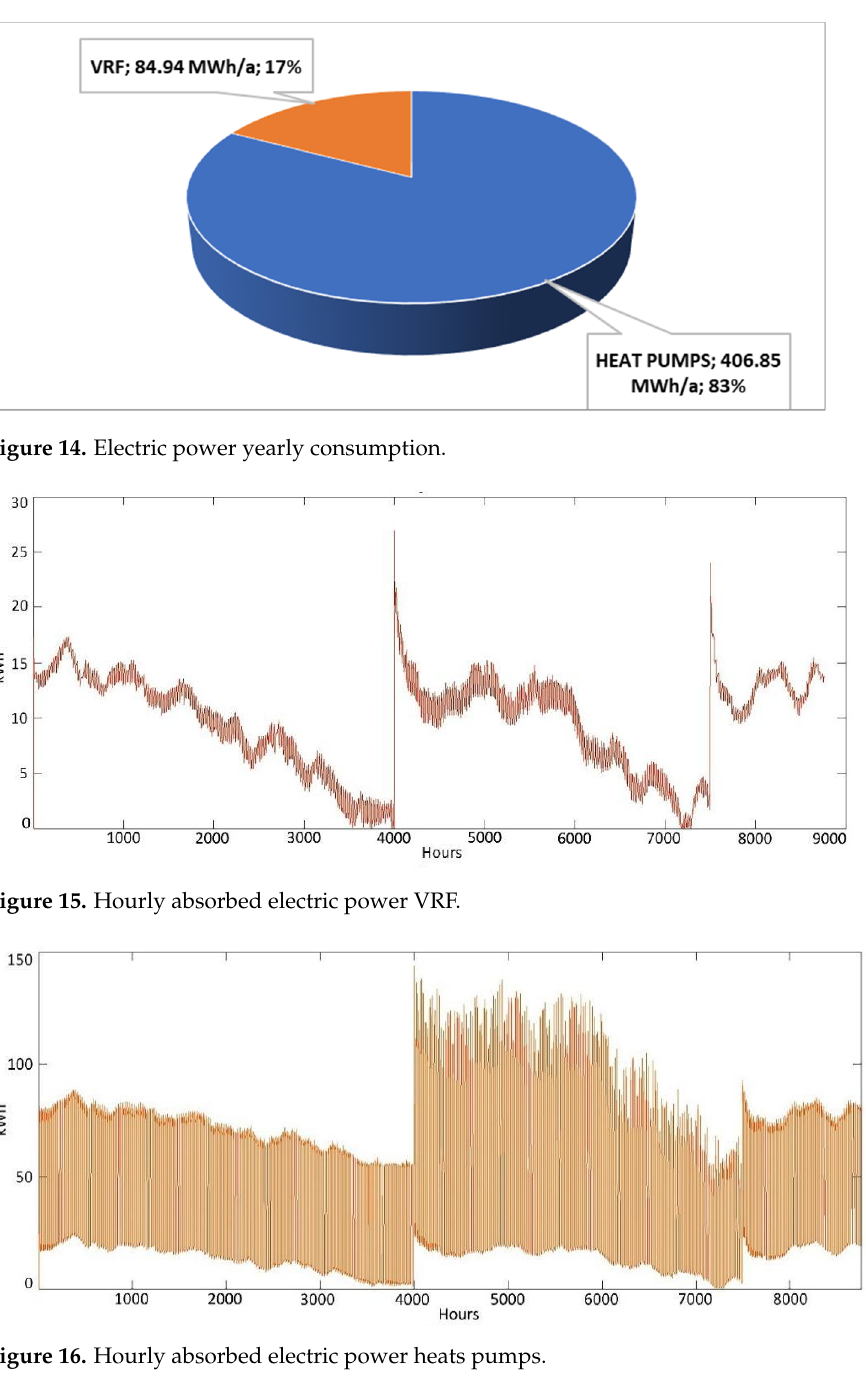
Figure 16. Hourly absorbed electric power heats pumps.